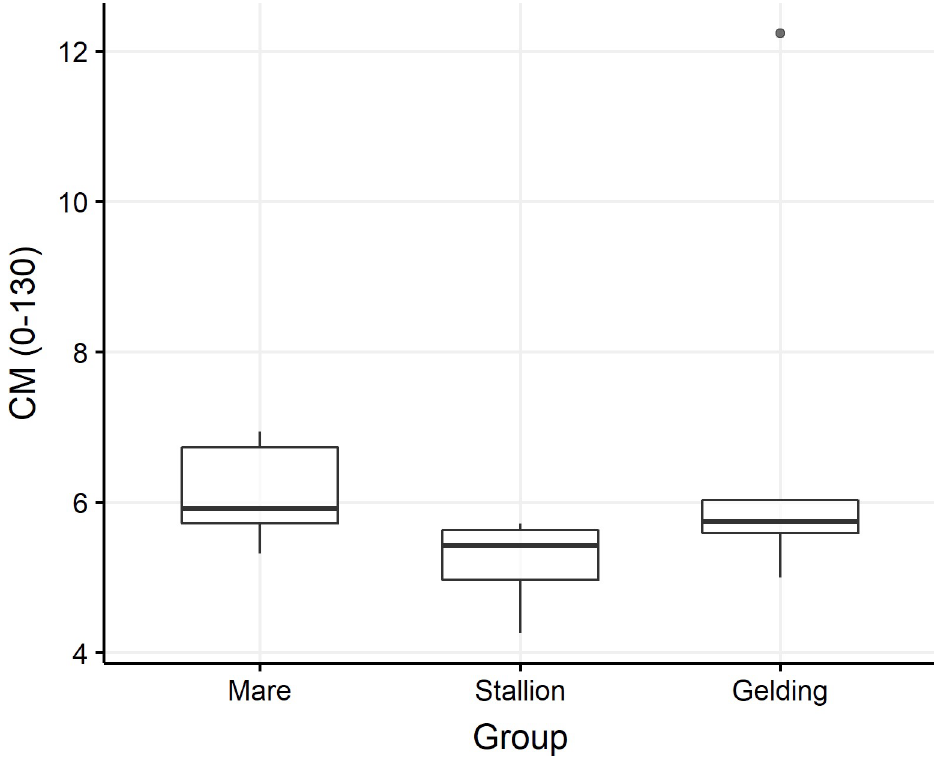
Fig 2. Corneometry values (CM) in the neck region. Data are expressed as a value in self units for the Corneometer 1 CM 825 probe. P < 0.05. The results were significantly higher between mares and stallions.